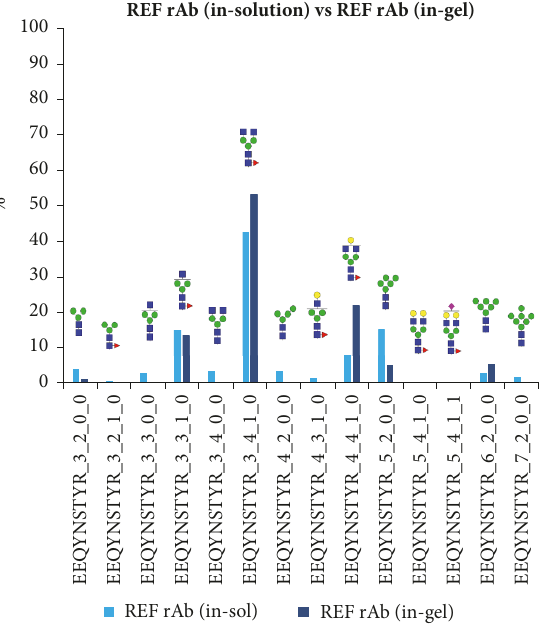
Figure 7: Comparison of the glycosylation patterns of the reference rAb, obtained, respectively, from the in-solution and the in-gel method. The two methods for sample preparation provided compa- rable results, implying that the in-gel method can be complimentary to the in-solution method for mapping protein glycosylation for our